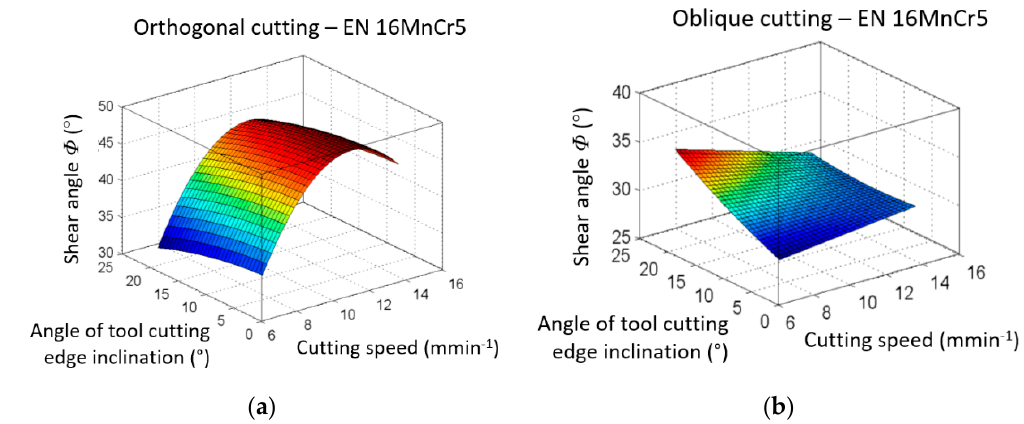
Figure 22. Dependence of shear angle Φ on cutting speed v c and angle of tool cutting edge inclination λ s ; ( a ) orthogonal cutting; ( b ) oblique cutting.